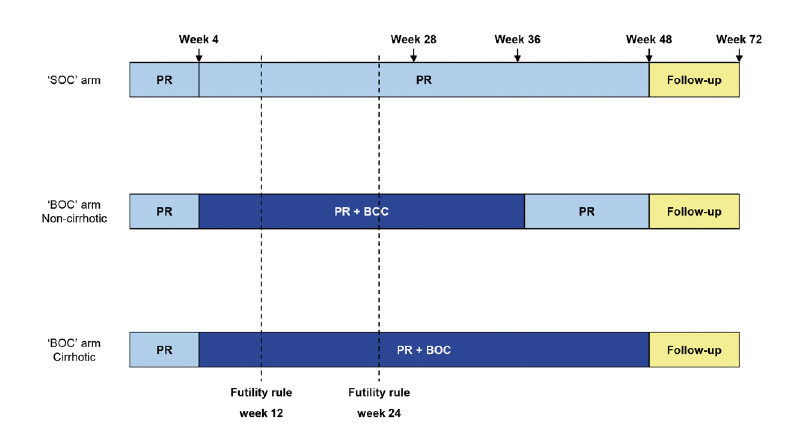
SOC=standard of care (pegylated interferon and ribavirin); BOC=pegylated interferon and ribavirin plus boceprevir;; HCV- RNA=hepatitis C virus ribonucleic acid; TW-treatment week Figure 3. Treatment Strategies in the Model (Treatment-experienced Patients)